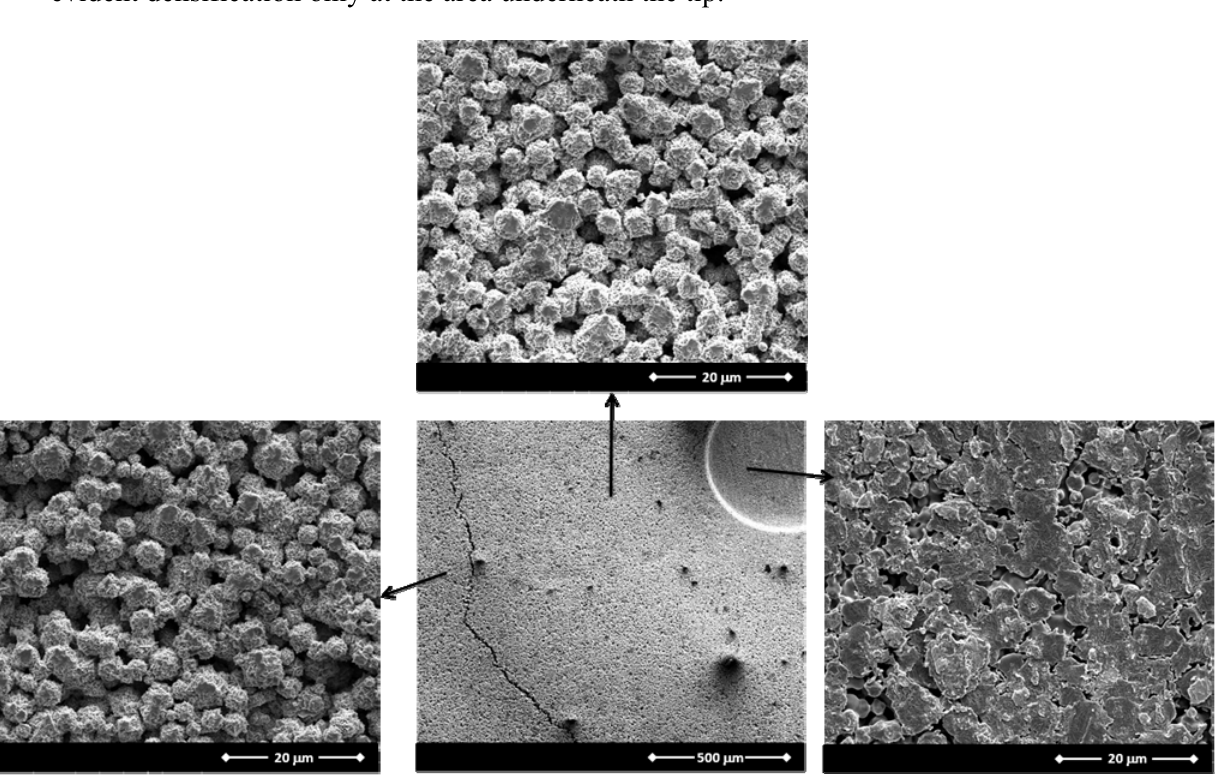
Figure 7. Scanning electron micrograph of a 55% initial green density specimen showing evident densification only at the area underneath the